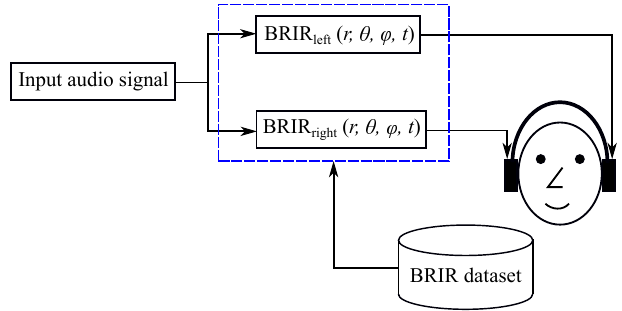
Figure 1. Illustration of the setup of BRIR